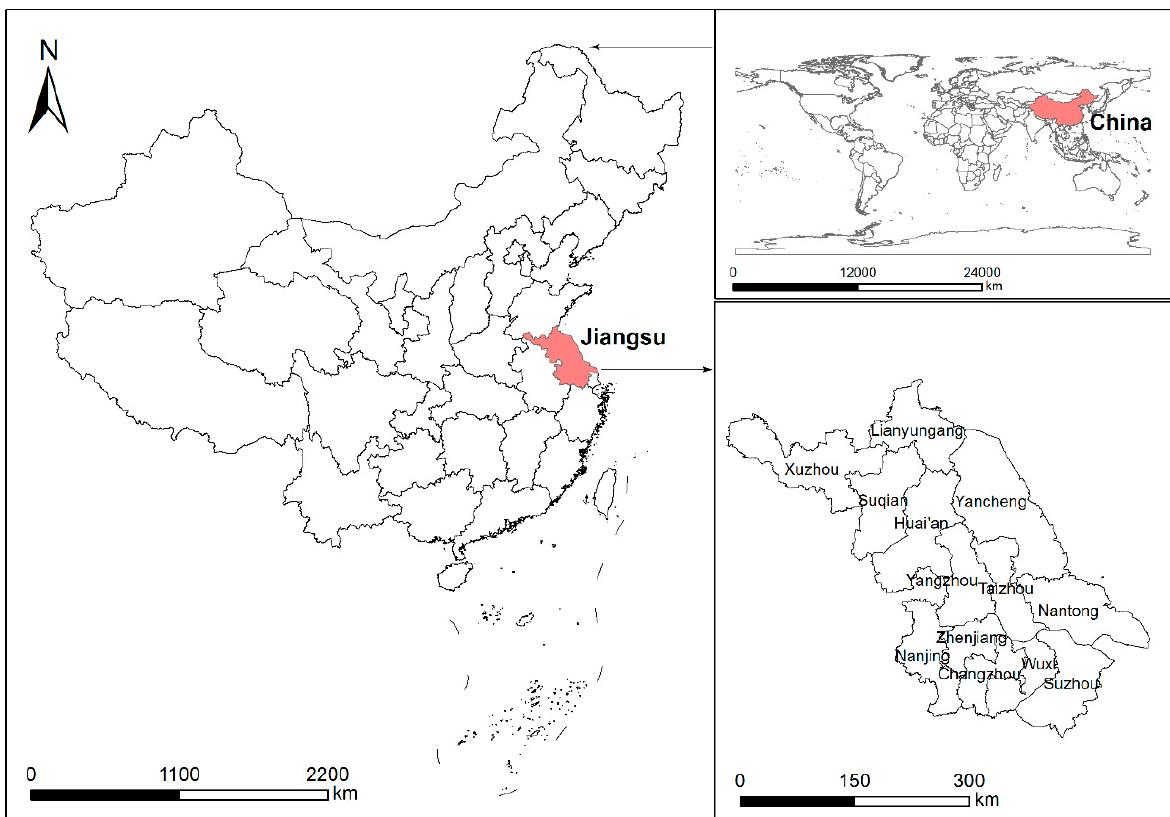
Figure 1. Distribution map of the sample area.